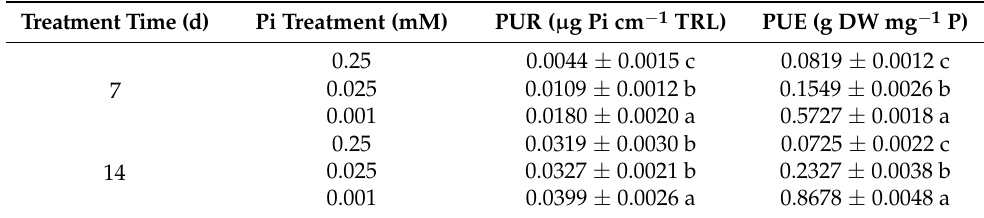
Table 4. The Pi uptake rate (PUR) and P utilization efficiency (PUE) under low-Pi stress. The values are presented as the mean ± SD ( n = 3). The lowercase letters indicate the significant differences in the parameter, at the same treatment time, among the treatments using one-way ANOVA with Tukey’s test ( p < 0.05).